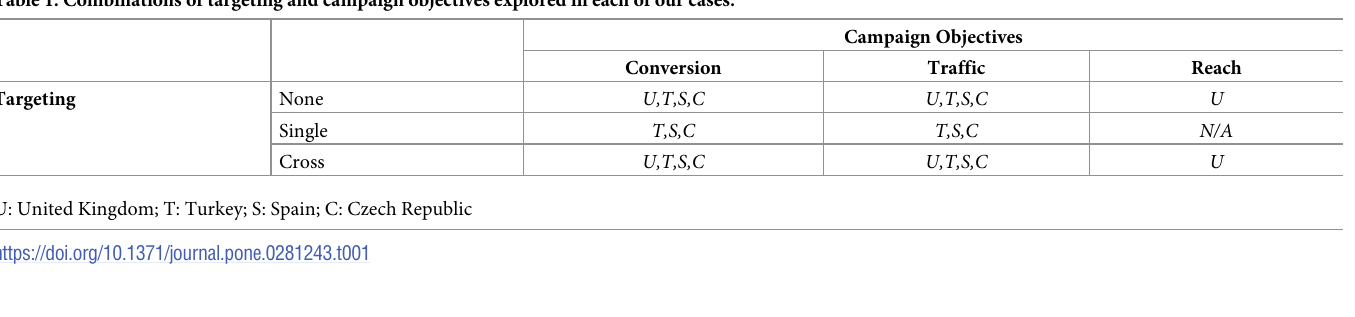
Table 1. Combinations of targeting and campaign objectives explored in each of our